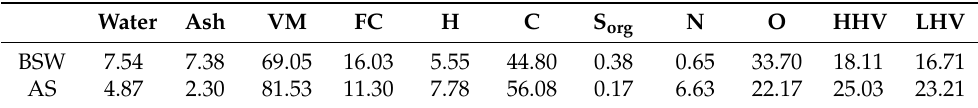
Table 1. Proximate and ultimate analyses of the birch wood shavings (BWS) and apricot stones (AS) used (as received, wt.%). VM—volatile matter, FC—fixed carbon; HHV—higher heating value, LHV—lower heating value (both